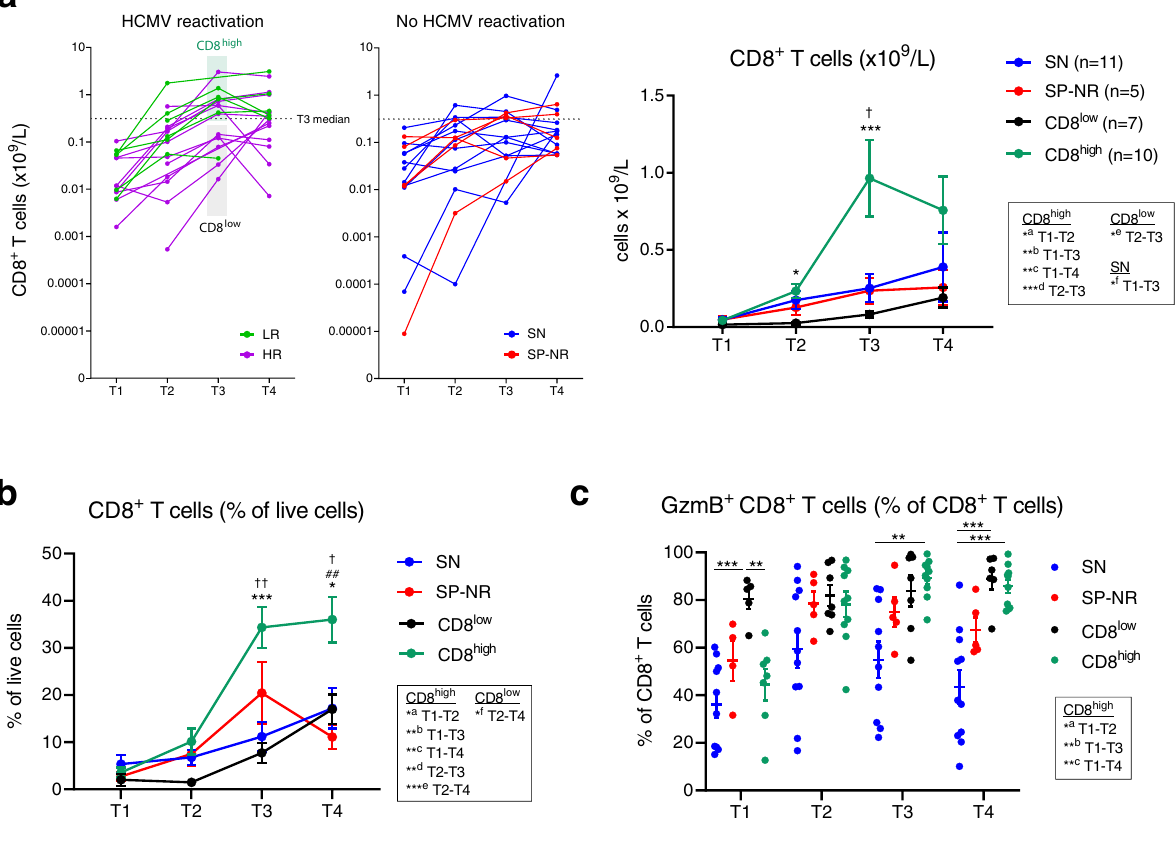
Fig. 4 Emergence of a CD8 + T cell dominated immune pro fi le in a subset of HSCT recipients with HCMV reactivation. a Absolute CD8 + T cell counts (x10 9 /L) in HSCT recipients with or without HCMV reactivation. Each line represents one patient. Dotted line indicates median CD8 + T cells across all patients at T3 (0.3116 × 10 9 /L). Reactivators were partitioned into ‘ CD8 high ’ ( n = 10) and ‘ CD8 low ’ ( n = 7) groups according to a CD8 + T cell-dominated signature at T3 in Fig. 3b. Graph on right: mean ± SEM, two-way mixed-effects model with Tukey ’ s multiple comparisons tests after log transform. On graph: * p = 0.0153 and *** p = 0.0002 for CD8 high (dark green) vs. CD8 low (black); † p = 0.0143 CD8 high vs. SN (HCMV-seronegative). Signi fi cant differences between pairs of time-points for patient groups are boxed: a p = 0.0118, b p = 0.0017, c p = 0.0043, d p = 0.0009, e p = 0.0384, f p = 0.0166. For T1, T2, T3 and T4 respectively: CD8 high ( n = 7, n = 10, n = 10, n = 10), CD8 low ( n = 5, n = 7, n = 7, n = 6), SN ( n = 11, n = 11, n = 10, n = 11), SP-NR ( n = 5 for all), in ( a ; right graph) and ( b ). b CD8 + T cells (percentage of live cells) in CD8 high reactivators (dark green), CD8 low reactivators (black), SN (blue) and SP-NR (seropositive no reactivation; red). Mean± SEM. On graph: CD8 high vs. CD8 low (*** p = 0.0005, * p = 0.0249), CD8 high vs. SN ( †† p = 0.0025, †